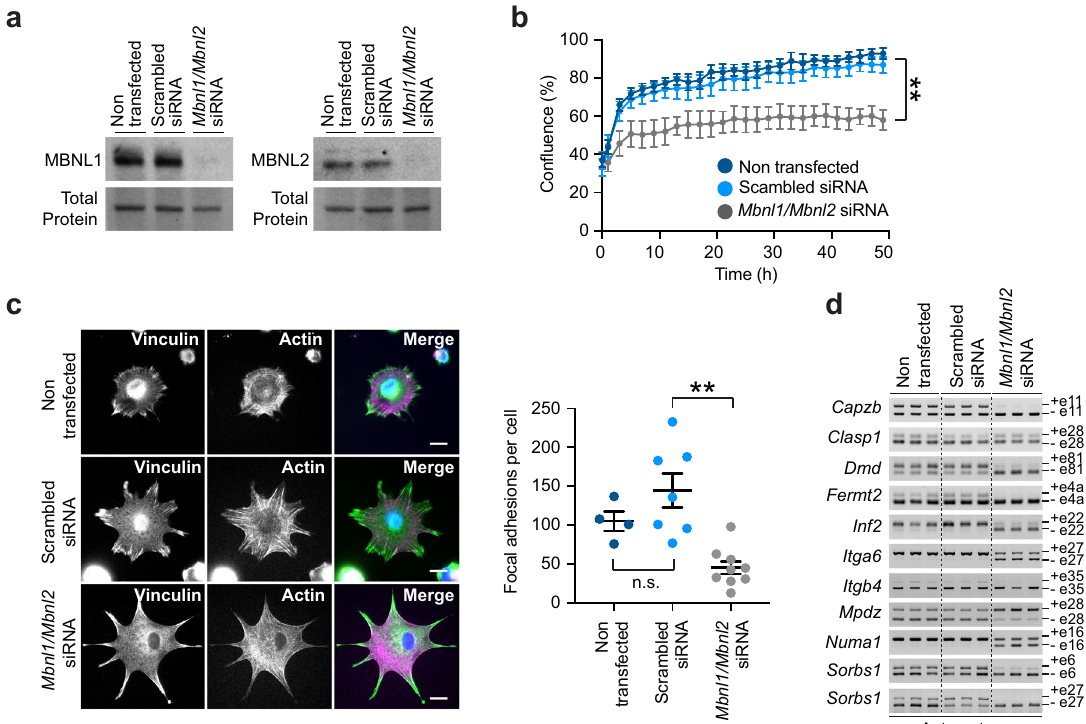
Fig. 8 MBNL1 and MBNL2 inactivation affects astrocyte cell growth, adhesion, and alternative splicing. a Western blot detection of MBNL1 and MBNL2 in double knockdown primary astrocytes, relative to scramble siRNA and non-treated controls. Representative stain-free protein bands are shown to illustrate total protein loading. The experiment was performed on two independent cultures per treatment. b Monitoring of the con fl uence of primary astrocytes by live cell video-miscroscopy, from 45 min after plating up to 48 h. Primary MBNL1/MBNL2 knockdown astrocytes are compared with non- transfected and scrambled-transfected controls. Data are means ± SEM, n = 4 independent cultures per genotype ( p = 0.0089, Two-way repeated measures ANOVA). c Immuno fl uorescent quanti fi cation of vinculin-rich focal adhesions per individual cell in siRNA-treated primary astrocytes,